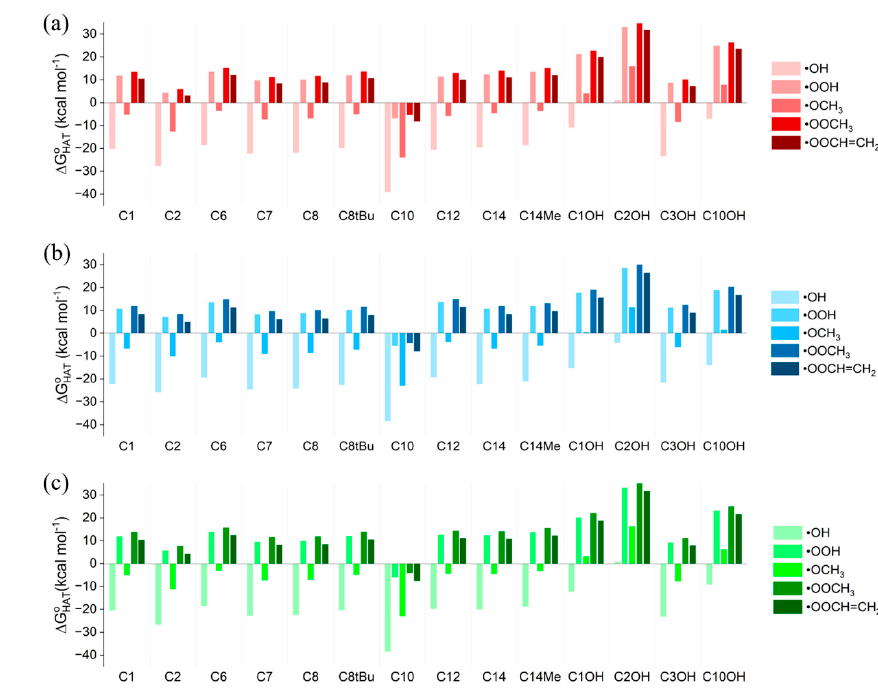
Figure 3. Gibbs free reaction energies ( ∆ G o HAT ) computed in ( a ) gas phase, ( b ) water and ( c ) benzene